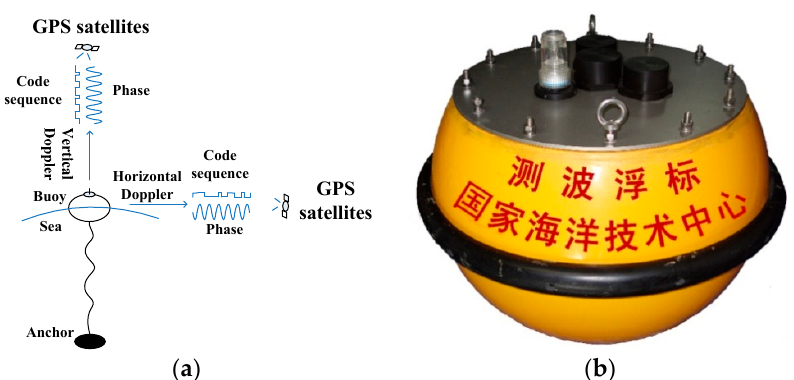
Figure 1. Measurement mechanism of the SBF7-1A GPS wave buoy developed by the National Ocean Technology Center in China: ( a ) schematic diagram; ( b ) physical picture.